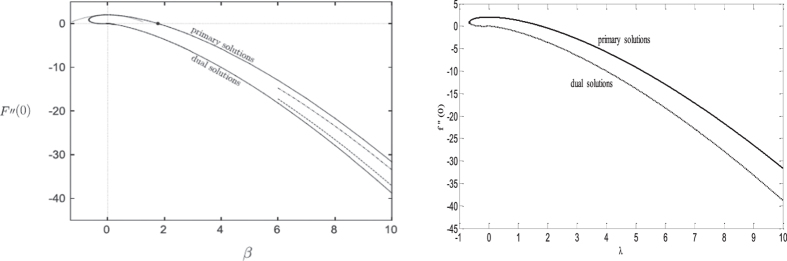
Comparisons of f″(0) when φ = 0, Pr = 1, S = 0 and λ = β (left Weidman11 and right the present results).